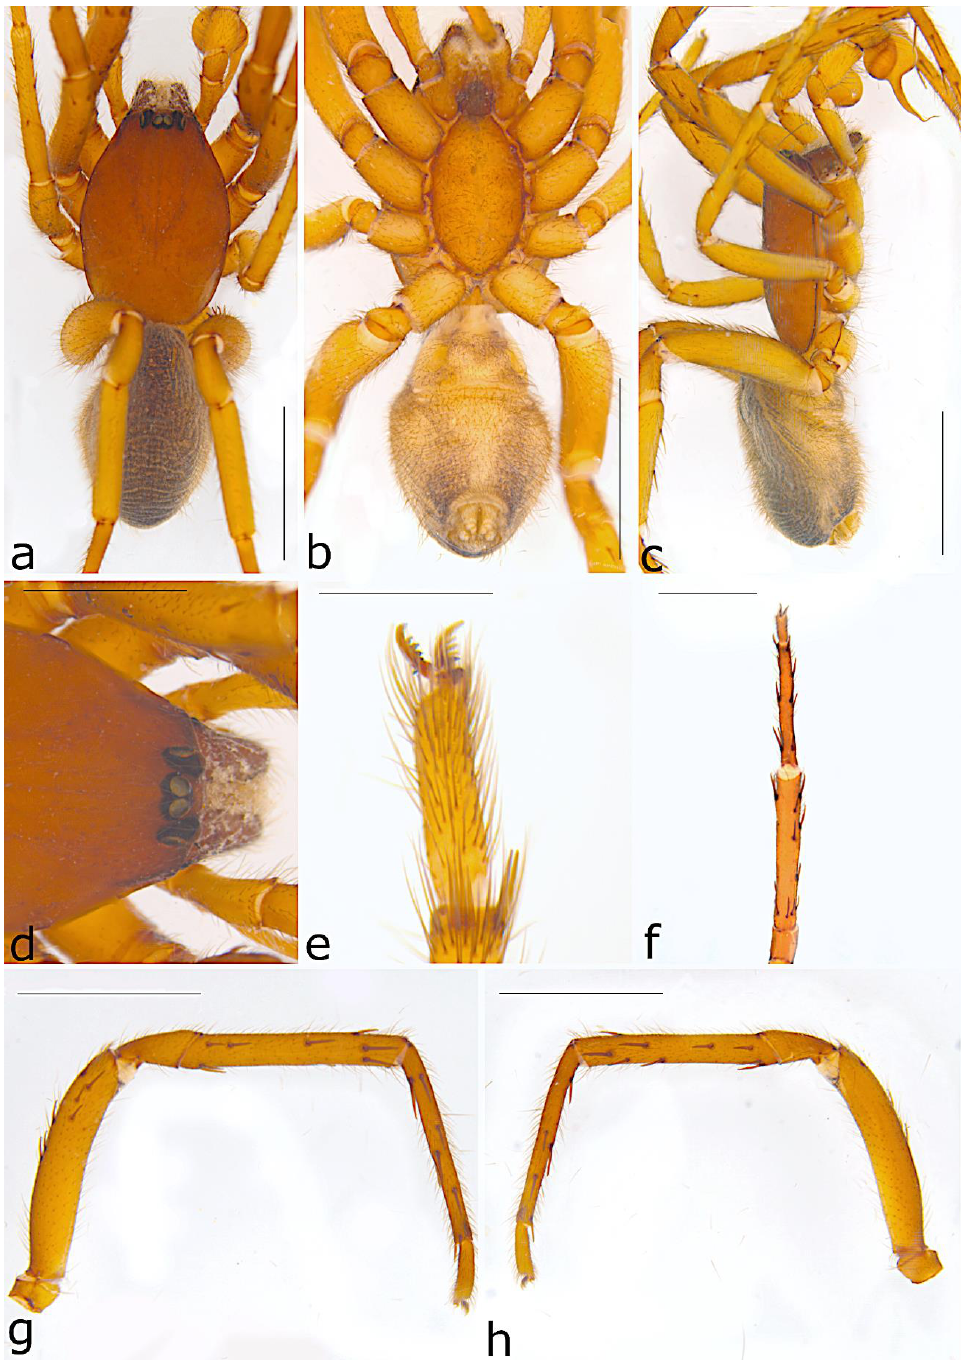
Figure 42. Ariadna insula sp. nov. ♂ holotype (SAMA NN30573) from Franklin Island (SA): ( a) habitus, dorsal view; ( b ) same, ventral view; ( c ) same, lateral view; ( d ) eyes, dorsal view; ( e ) left metatarsus IV, preening comb, retrolateral view; ( f ) left leg I, ventral view; ( g ) same, prolateral view; ( h ) same, retrolateral view. Scale bars ( a – c ) = 2 mm, ( d ) = 1 mm, ( e ) = 0.5 mm and ( f – h ) = 2 mm.